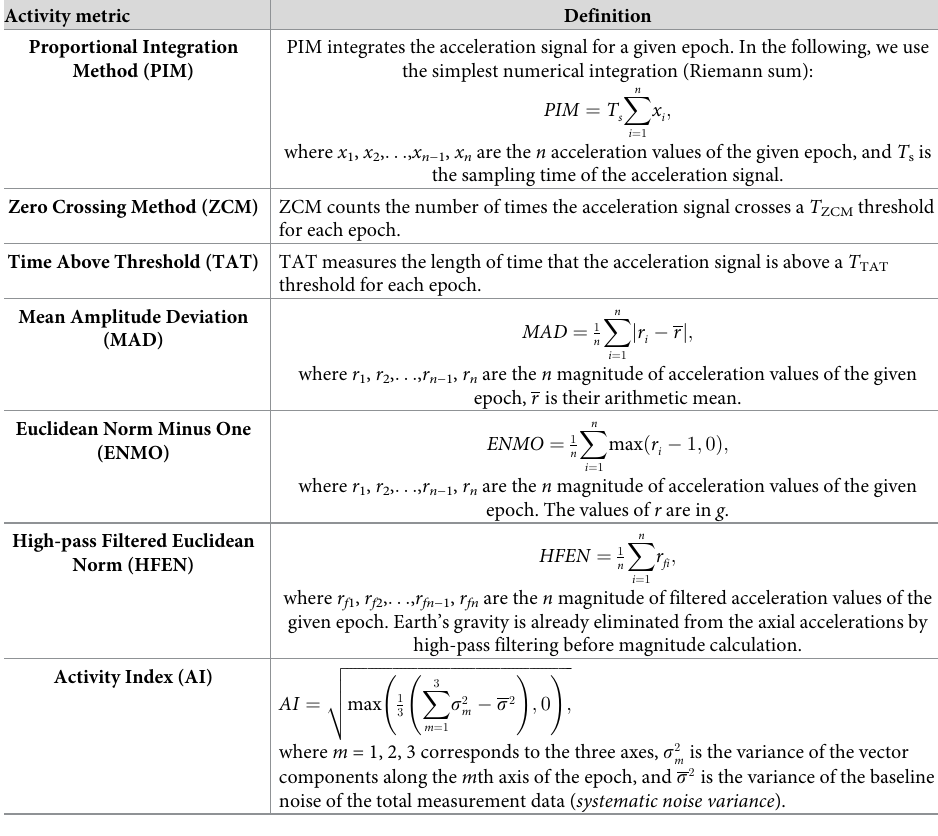
Table 1. The 7 activity metric definitions from the actigraphy literature compared in this